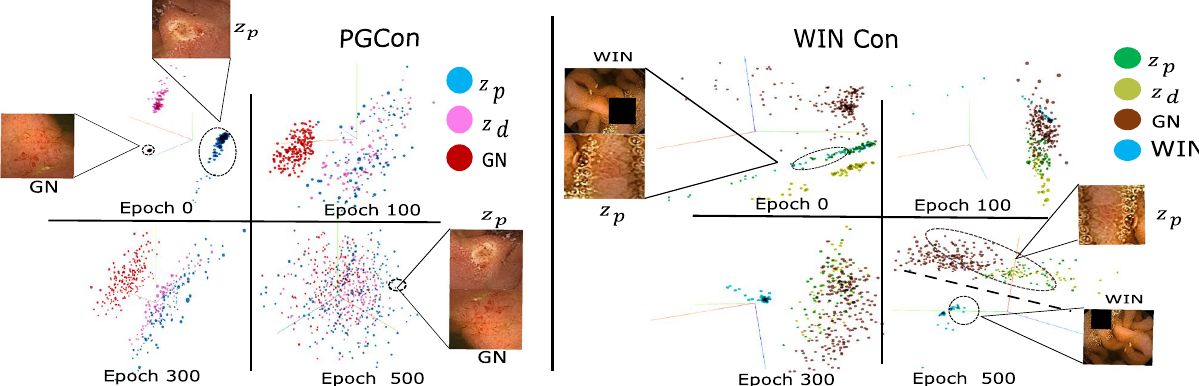
Figure 3. Evolution of the embedding space: PCA of 128d feature vectors for z p , z d , Global Negatives (GN) and WIN. PGCon: initially the embeddings start as separate localized clusters corresponding to z p , z d and global negatives, but as the embeddings slowly specialize in pathology regions (start exhibiting invariance to other factors), the embeddings are seen to merge and spread out to a space of pathologies. WINCon: initially the WINs lie close to corresponding prior views ( z p ) due to being parts of the same image. However, interestingly, as the embeddings get more and more specialized in pathologies, the same WINs are pushed away from pathology based embeddings i.e., z p and GNs. Despite the WINs being very diverse, a dense WIN cluster suggests a tendency towards invariance to normal variations and high variance towards